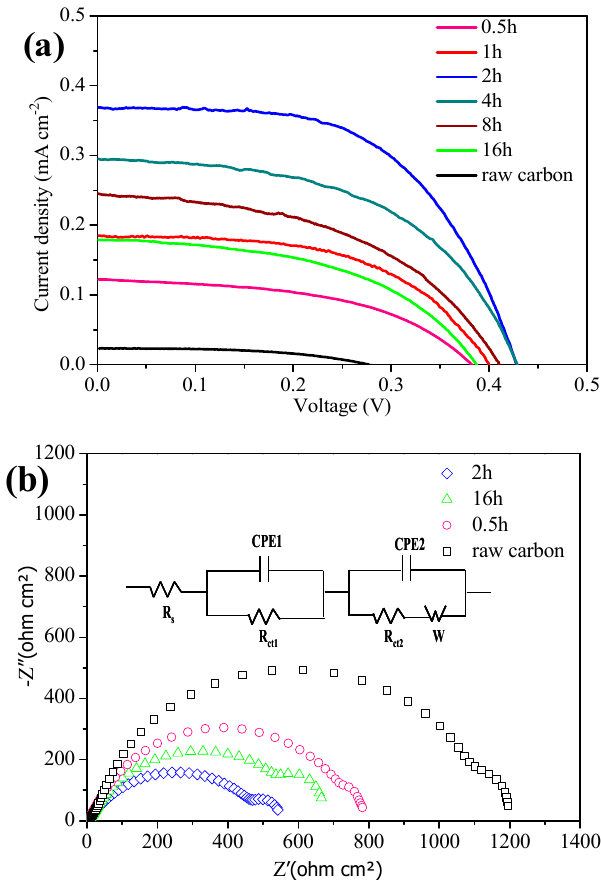
Figure 2. ( a ) Characteristic photocurrent density–voltage ( J – V ) curves for N-CQDs sensitized solar cells under simulated sunlight (AM1.5, 100 mW cm − 2 ), ( b ) Nyquist electrochemical impedance spectroscopy (EIS) plots and an equivalent circuit for N-CQDs sensitized solar cells. Table 1. Photovoltaic parameters of N-CQDs sensitized solar cells obtained from J–V measurements. J sc : short-circuit current density, V oc : open-circuit voltage, FF : fill factor. Heating Time